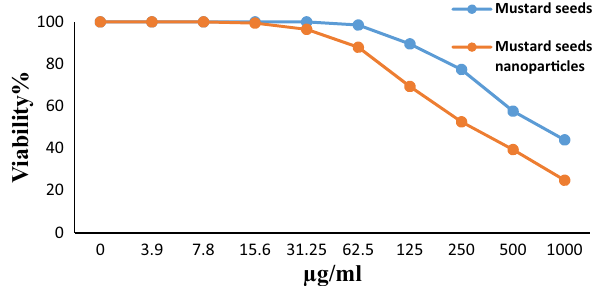
Figure 6: Evaluation of cytotoxicity of mustard seed and its nano formulation against MCF -